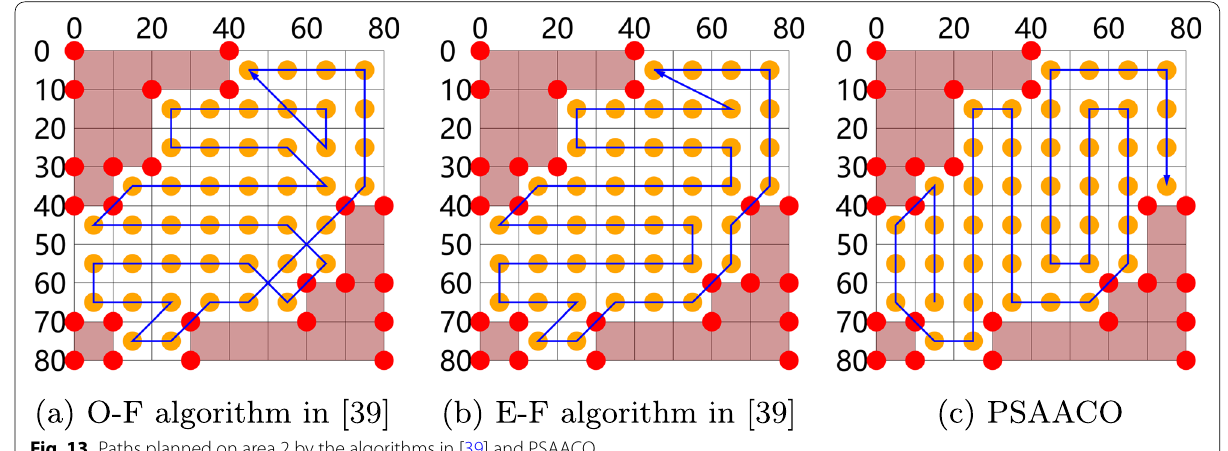
Fig. 13 Paths planned on area 2 by the algorithms in [39] and PSAACO